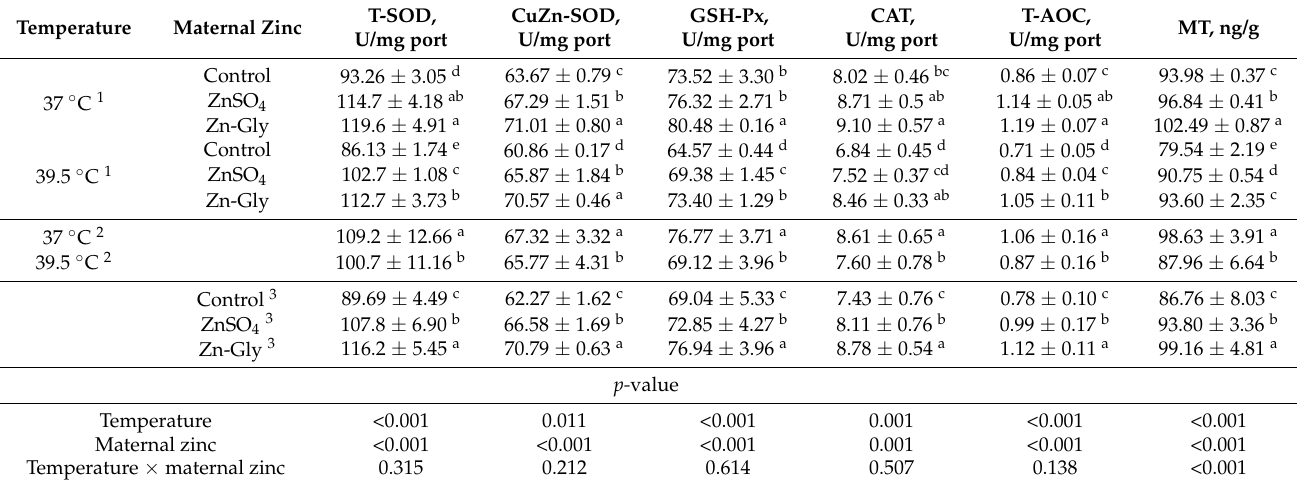
Table 5. Effects of maternal zinc on oxidative indicators and HSP70 in embryos under heat stress (mean ± S.E.).